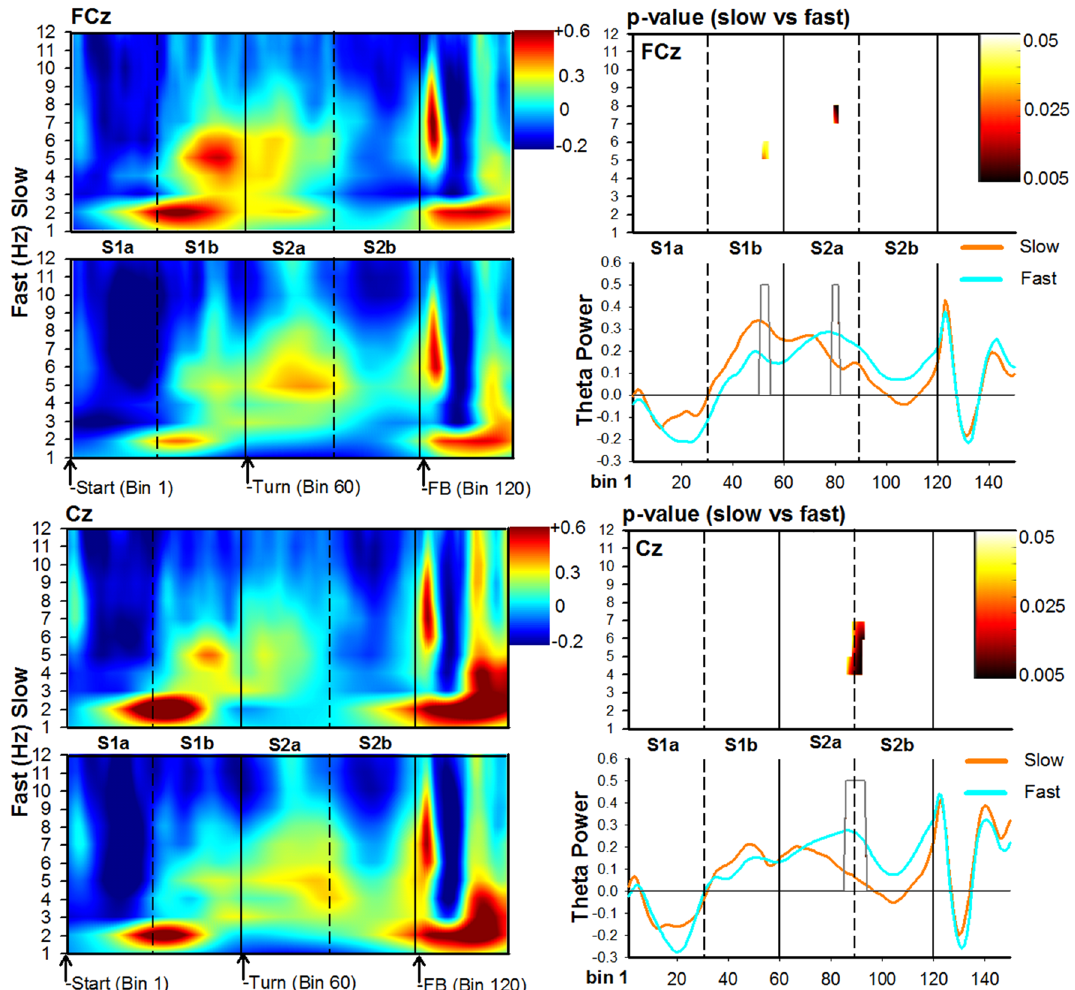
Figure 6. Time–frequency analysis of the EEG associated with trial walking speed for frontal-midline channels FCz (top) and Cz (bottom). For each channel location, panels depict time–frequency power maps (left panels), p-value maps (right-top panel), and theta time-course (right-bottom panel) for the slow (orange solid lines) and fast (cyan solid lines) conditions. The X-axis represents Bin location and maze subregion. The Y-axis for power and p-value maps represents frequency ranges from 0 to 12 Hz, and the Y-axis for the theta time-course represents a change in power . For all conditions, Bin 0 represents the start of the trial. The color bar for time– frequency plots represents the power of the oscillations depicting greater activity in warm colors. The heat-maps (left-top panel) represents the p-values (range 0.05 to 0.005) comparing slow vs fast trials. The grey bars depicted in the theta-time course maps represent significant Bins identified in the